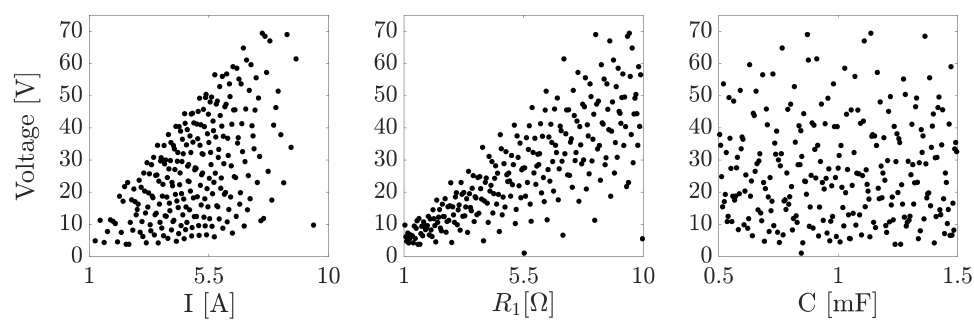
Figure 13. Scatter plots of v C versus I , R 1 , and C after running a Monte Carlo simulation at t = 40